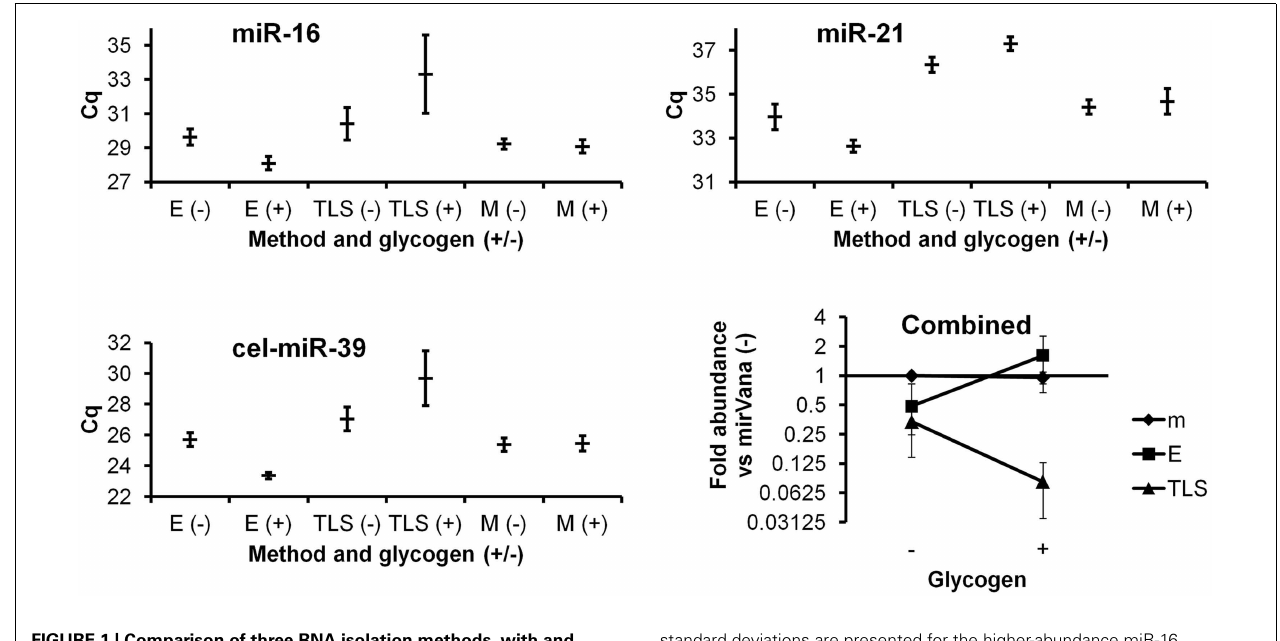
FIGURE 1 | Comparison of three RNA isolation methods, with and without glycogen . miRNAs from plasma RNA isolated in triplicate by the three indicated methods (E, Exiqon Cell and Plant kit;TLS,TRIzol LS; M, mirVana isolation kit), with and without glycogen, were assessed by RT-qPCR in triplicate. Results based on two endogenous and one spiked-in exogenous miRNA are shown. Raw Cq averages and